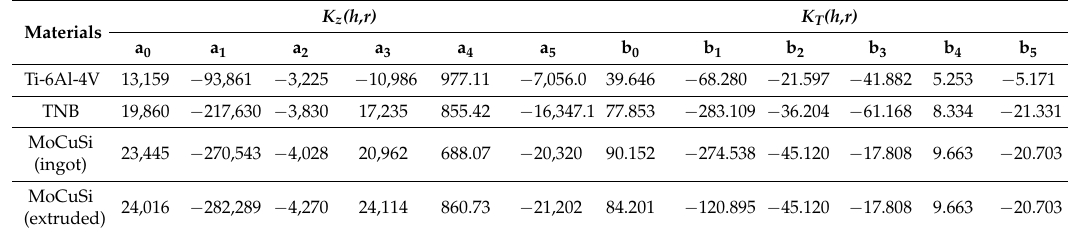
Table 8. Obtained coefficients for the polynomials in Equations (3) and (4).